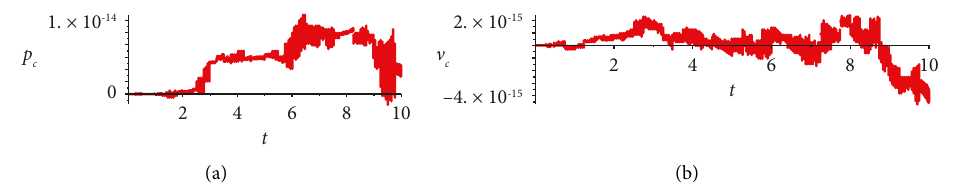
Figure 6: The error in the position constraint g ( u ) � 0 (a) and the error in the velocity constraint g